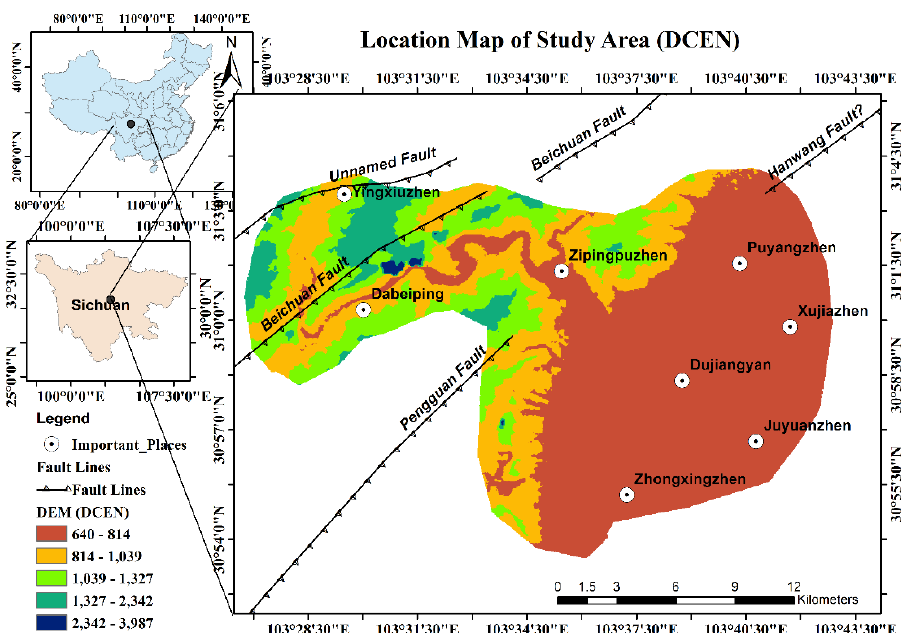
Figure 1. Location map of the study area in Dujiangyan City and its environs (DCEN) in SW China; in the left panel, the top and bottom inset maps show the location of Sichuan province within the boundary of China and the DCEN within Sichuan province, respectively. The right panel indicates the digital elevation model (in meters), including overlay of important places (marked as white circles with black dots) and geological fault lines.